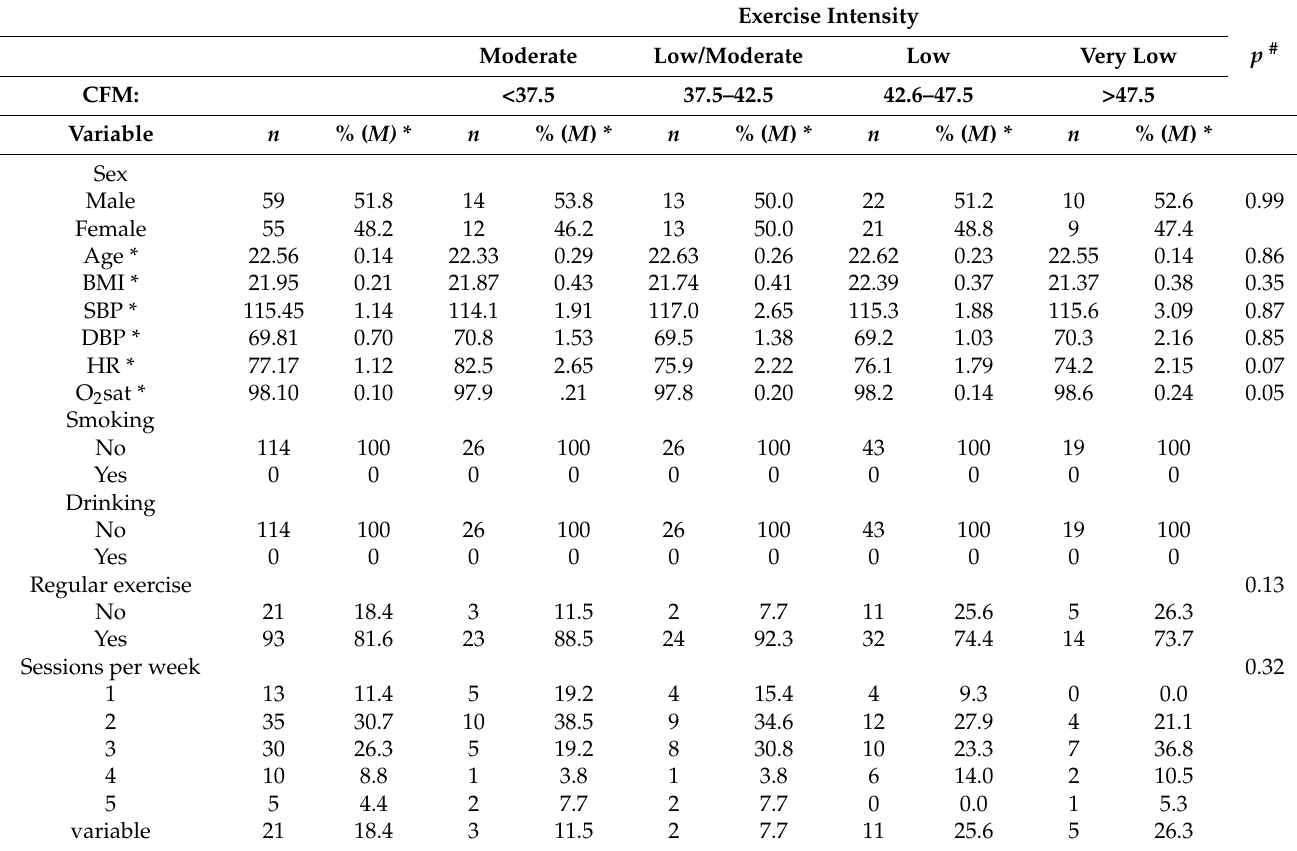
Table 1. Participant characteristics and group differences ( N =